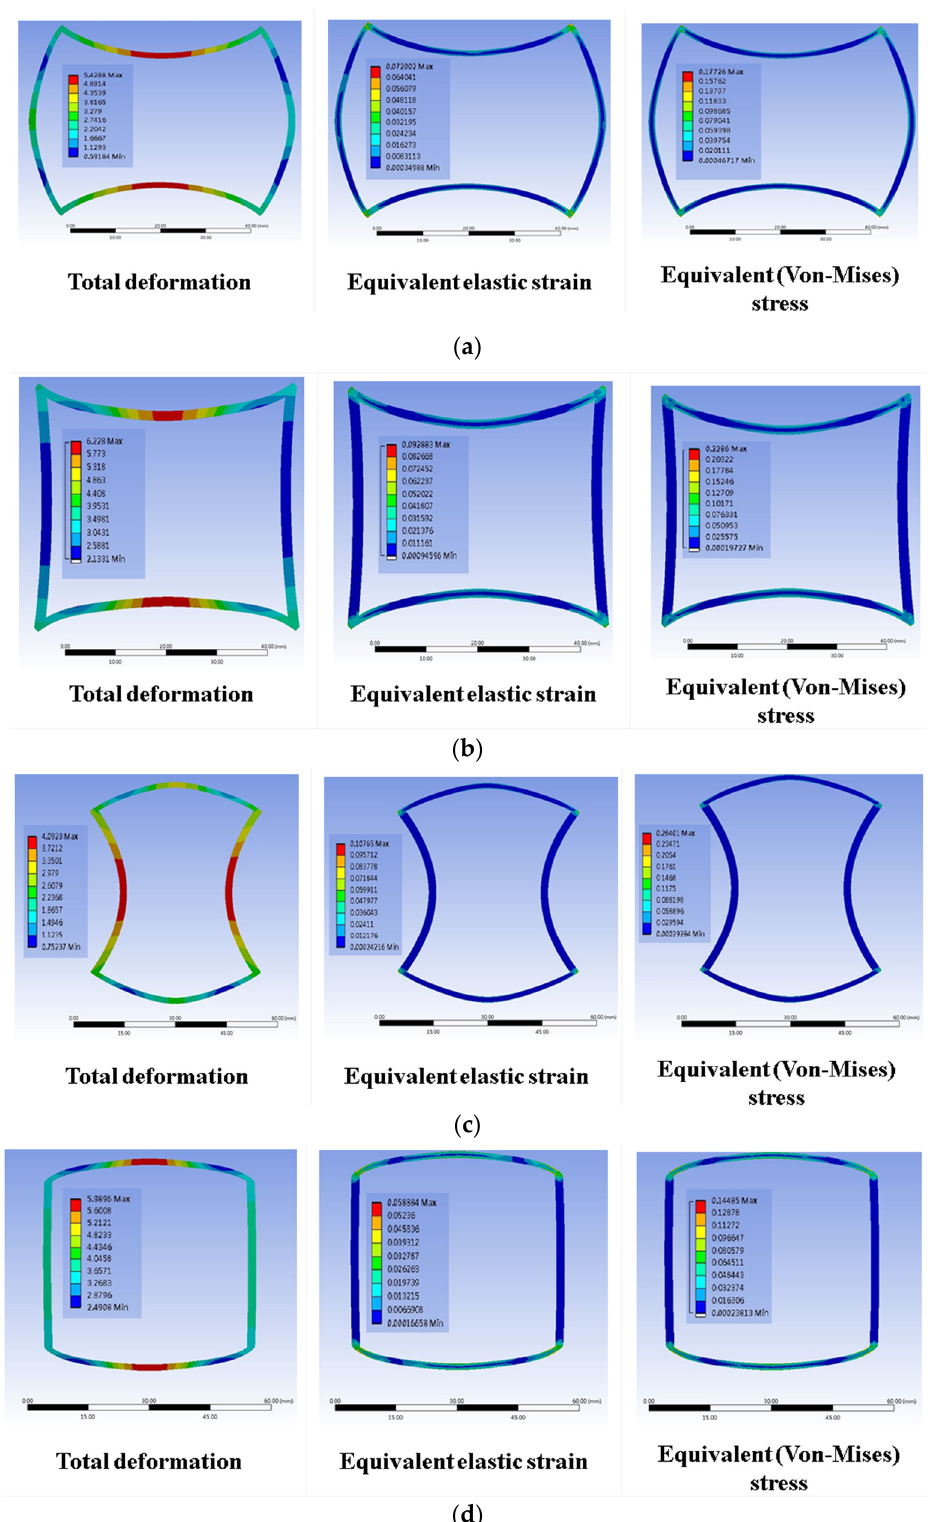
Figure 9. Simulation of SIN waveforms with 2.5 mm of uniaxial stretching: ( a ) A, ( b ) A’, ( c ) B, and ( d ) B’ types. In addition, they were arranged as 3 × 3 arrays (Figure 10) and 4 × 4 arrays.